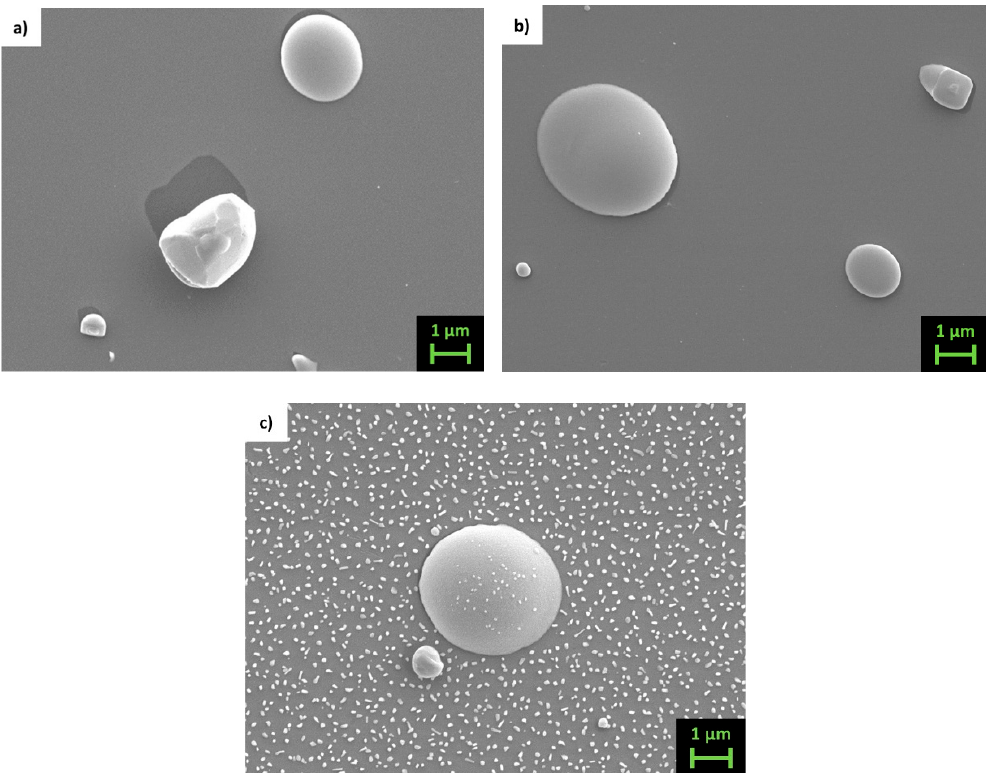
Figure 6. Top view LED-SEM images of samples ( a ) Fe70_RT, ( b ) Fe70_ann and ( c ) Fe70_423.